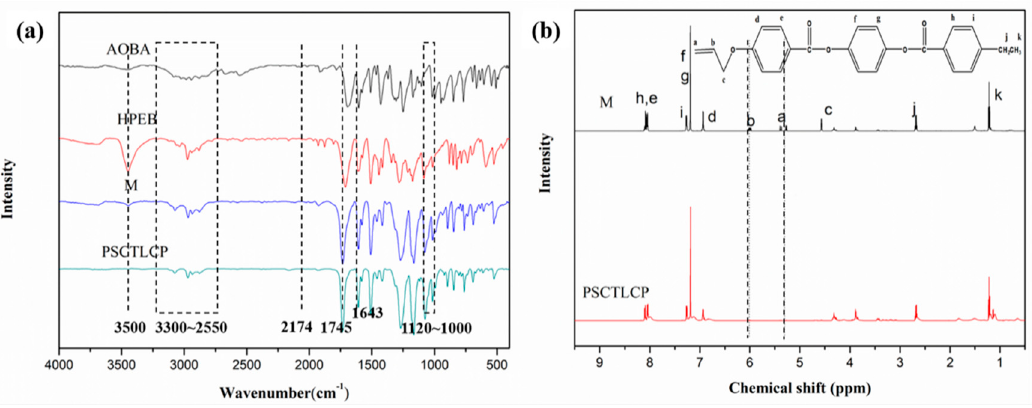
Figure 1. ( a ) FT-IR spectra of AOBA, HPEB, M, PSCTLCP, ( b ) 1 H NMR spectra of M and PSCTLCP in CDCl 3 .